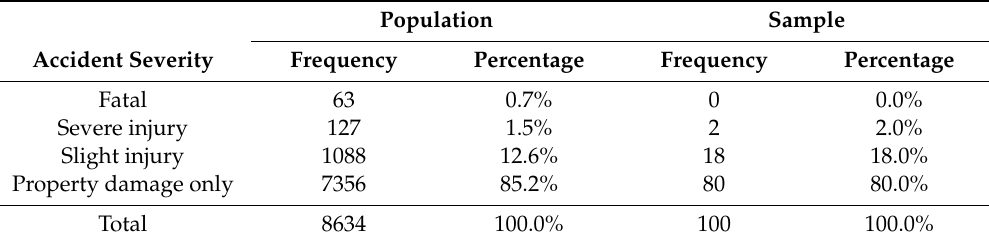
Table 4. Comparison of accident severity levels between population and the studied sample.